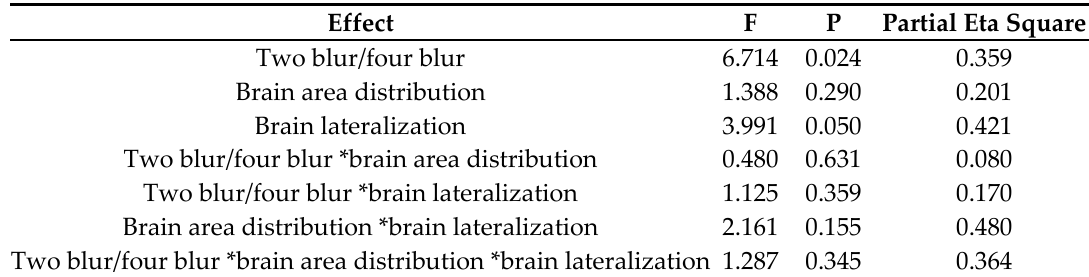
Table 4. The results of 200~400 ms in the experimental group.